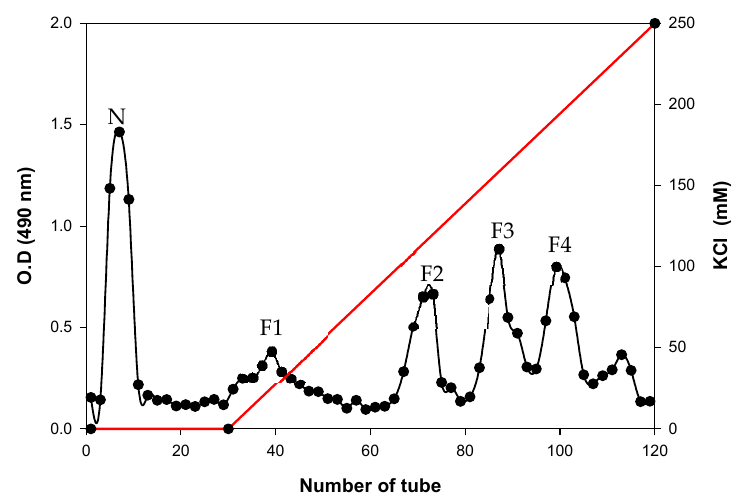
Figure 1. DEAE-Sephadex chromatography of neutral and anionic CG fractions from Sinorhizobium meliloti 1021.